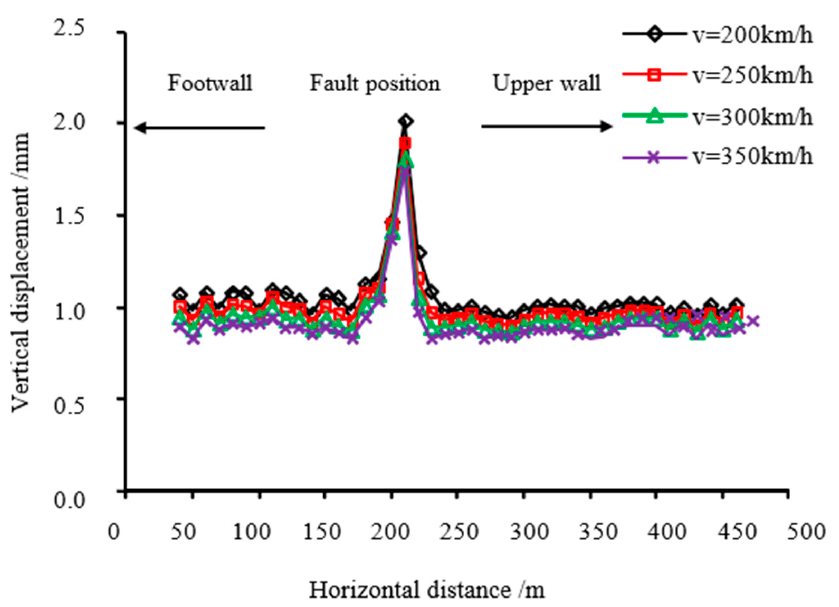
Figure 11. Vertical displacement distribution curve of surface soil along high-speed railway line at different vehicle speeds.